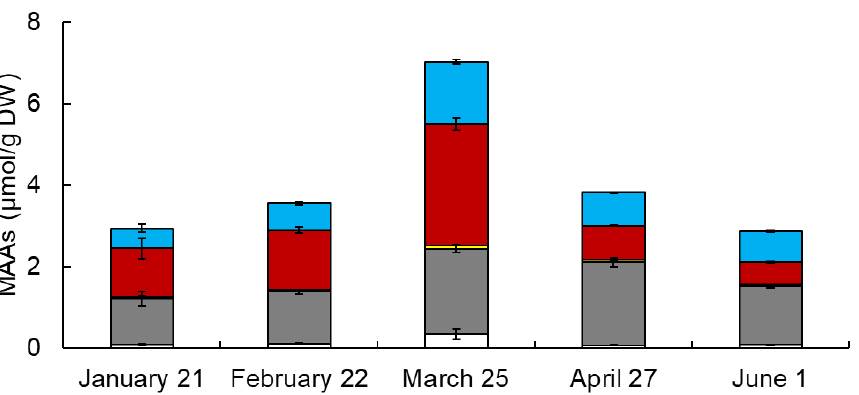
Figure 1. MAAs in 2021. The content of six MAAs—shinorine, palythine, asterina-330, porphyra-334, and usujirene + palythene—in dulse collected on 21 January, 22 February, 25 March, 27 April, and 1 June. Data show mean values, n = 3.